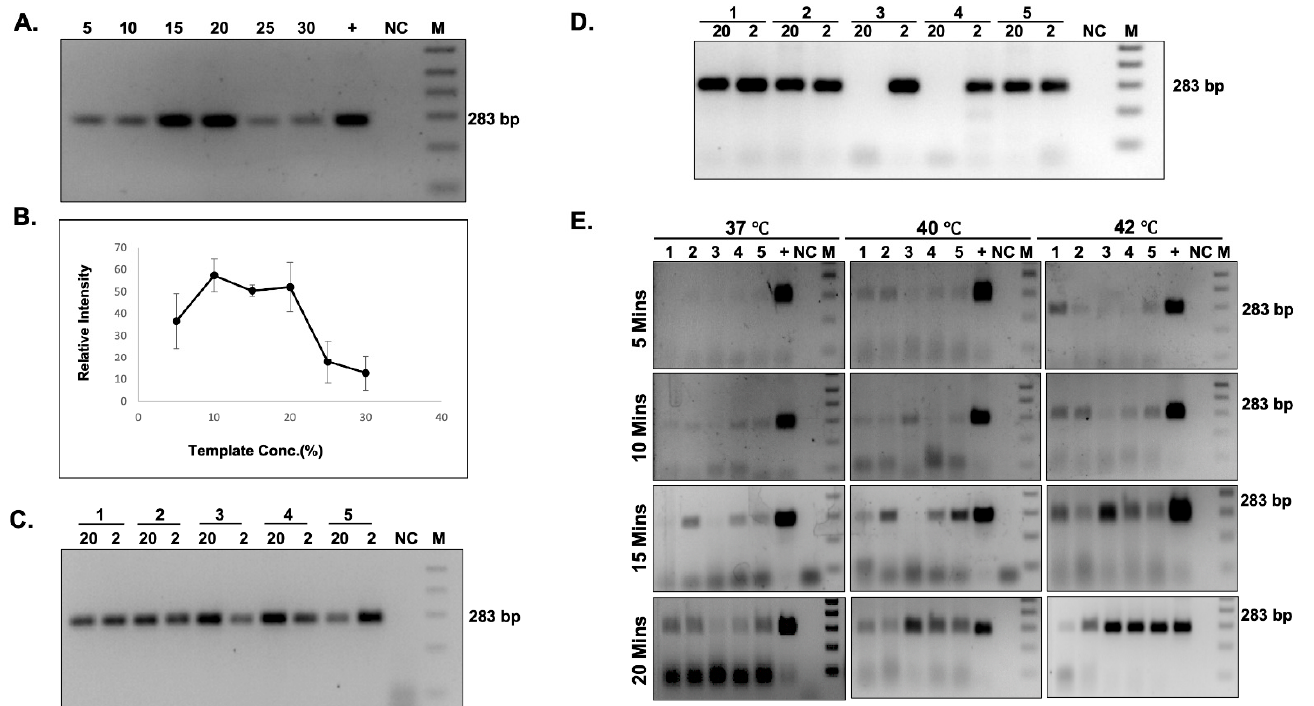
Figure 3. Effect of temperature, time, and concentration of buccal swab lysates on iDA. ( A ) iDA with varying buccal swab lysate concentrations (%) and ( B ) relative quantification = 3. Amplification sensitivity with high (20%) and low (2%) buccal swab lysate concentration in ( C ) iDA and ( D ) qRT-PCR; n = 5. ( E ) Sensitivity of iDA at different temperatures and timepoints n = 5. Next, the effect of temperature and time on the amplification efficiency was assessed.